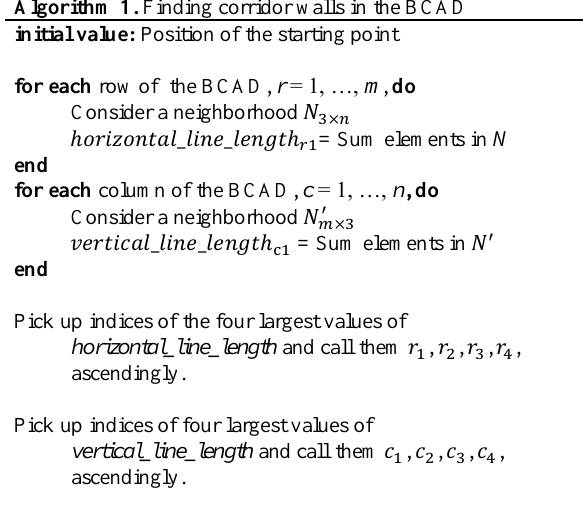
Algorithm 1. Finding corridor walls in the BCAD